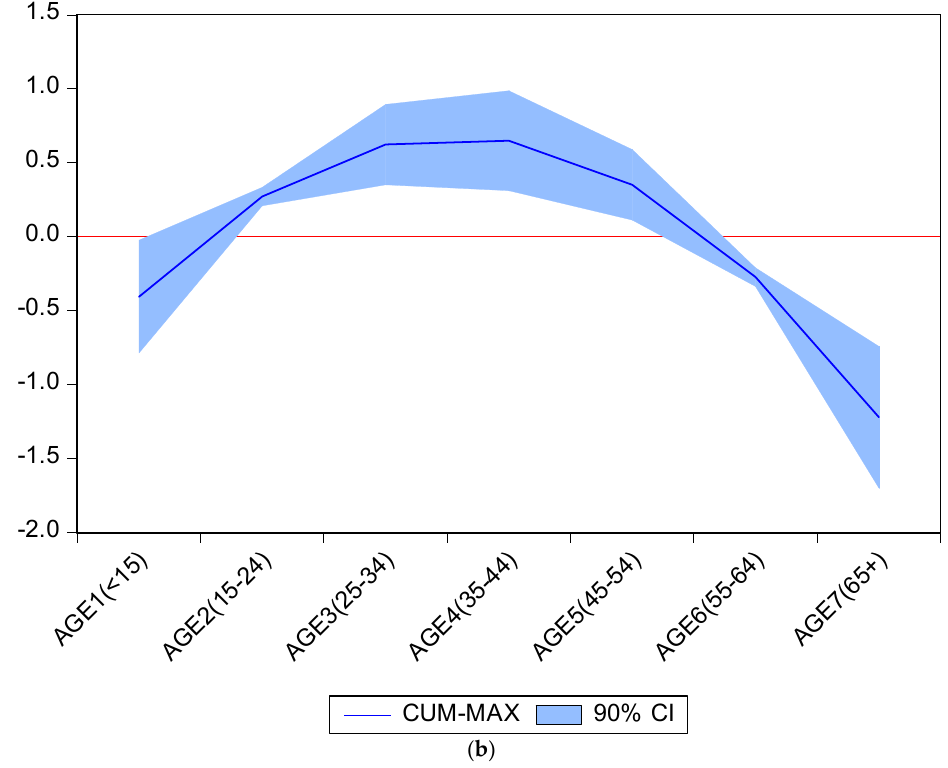
Figure 2. The effect of age distribution on copayment policy responses. ( a ) Effect of age distribution on the maximal responses of medical center outpatient visits to the change in copayment from medical centers. ( b ) Effect of age distribution on the accumulative maximal response of medical center outpatient visits to simultaneous change of copayment from all providers.